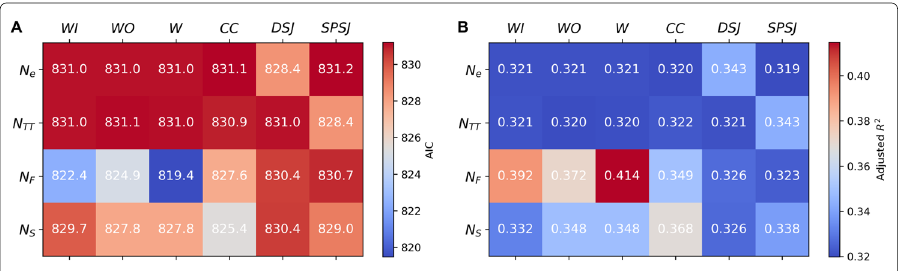
Fig. 6 a AIC and b adjusted R 2 of ordinary least squared regression models using different node level network statistics